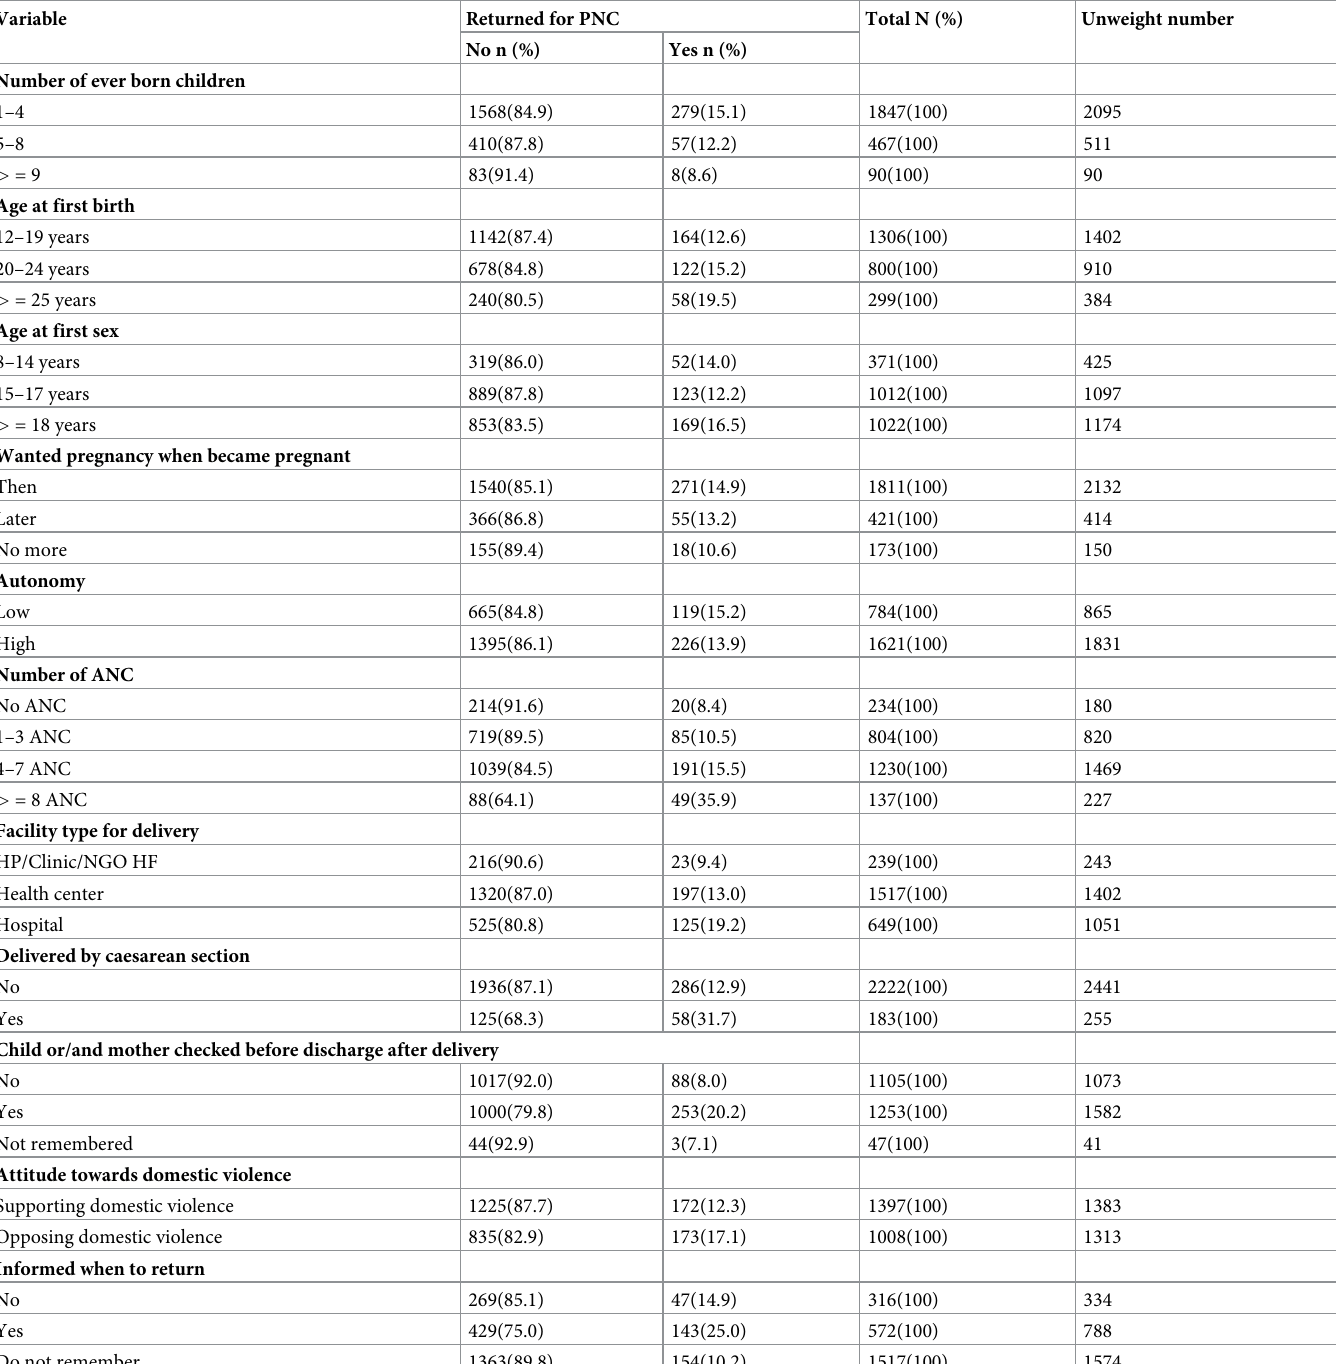
Table 2. Gynecological/Obstetrical characteristics and related service utilization among participants, analysis from the 2016 EDHS, (N = 2405).